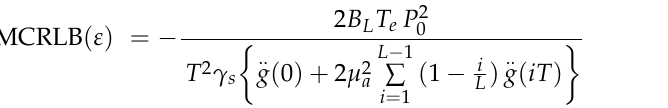
√ Th ( t ) with respect to t evaluated at t 0 ,